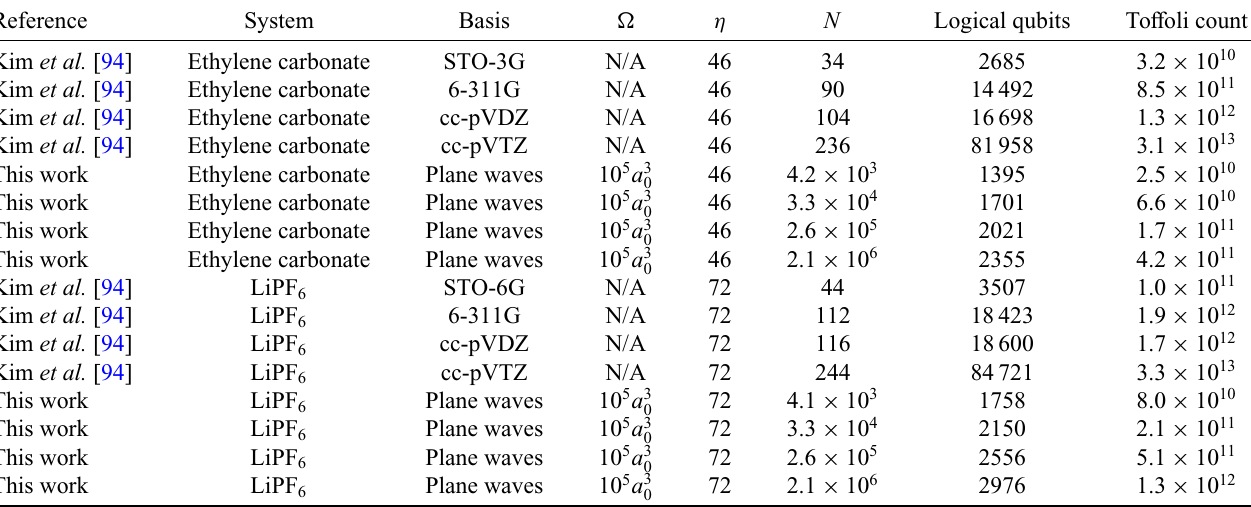
TABLE VII. Table comparing the cost of the qubitization algorithm of this paper to the cost of a state-of-the-art second quantized Gaussian basis algorithm recently analyzed by Kim et al. [94]. The work of Kim et al. estimates the resources required to simulate systems, which despite being small single molecules, are presented as relevant to the chemistry of lithium batteries. Their estimates are a natural point of comparison because they do not employ active spaces, unlike the focus of most past work using molecular orbitals [22,26,27,38,95]. We focus on two representative molecules from that work: ethylene carbonate and LiPF 6 , discretized using four different Gaussian orbital basis sets. We note that the algorithm of Lee et al. [27] has been shown to scale better than the algorithm of von Burg et al. [26], on which the work by Kim et al. is based, but all resource estimates using that approach involve active spaces. We expect that in most contexts, if one uses a number of plane waves that is more than a thousand times the number of orbitals in a given Gaussian basis set, then one can expect similar or higher precision from the larger plane-wave calculation, even for small nonperiodic systems like the ones analyzed here. This would suggest that for N = 2.6 × 10 5 plane waves, our algorithms may achieve higher precision than even the correlation consistent triple zeta (cc-pVTZ) basis set calculations studied by Kim et al. [94]. Thus, the results in this table may suggest that our algorithms requires significantly less surface-code space-time volume to reach similar levels of precision compared to some of the most performant Gaussian-based